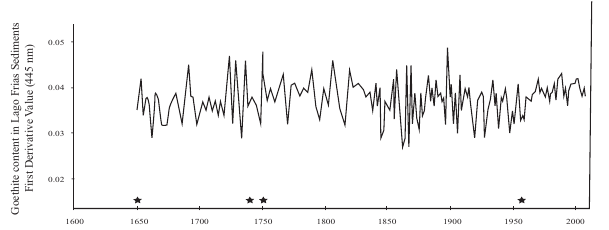
Fig. A1. Goethite (derivative 445nm) chronology of Lago Fras varved lake sediments. Stars represent some well-known earth- quakes in the area (AD 1960; AD 1751, and AD